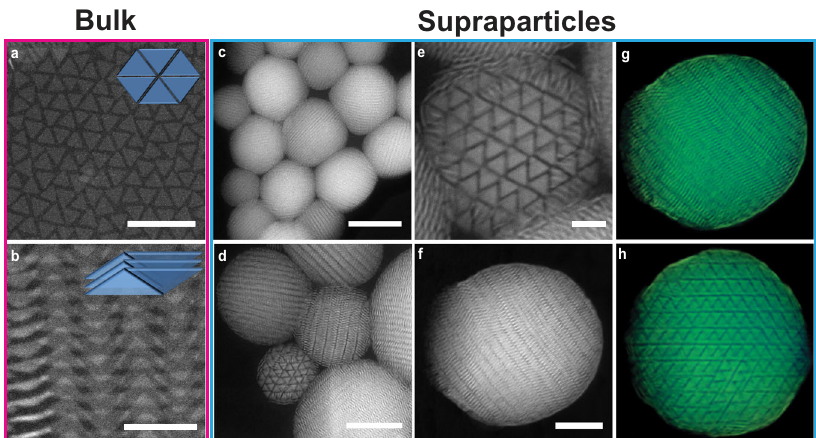
Fig. 5 | SPs composed of triangular LaF 3 NPLs. 2D HAADF-STEM images of self- assembledsuperlatticescomposed of triangularLaF 3 NPLs a withtheir fl atface up, b showing an interdigitated ribbonlike array. c Overview and d a zoom-in view of the self-assembled SPs showing different orientations. e An enlarged view of a SP showing a wallpaper p2 symmetry, with the basal planes of the NPLs orienting towards the con fi ning interface. f 2D HAADF-STEM image of a SP for electron